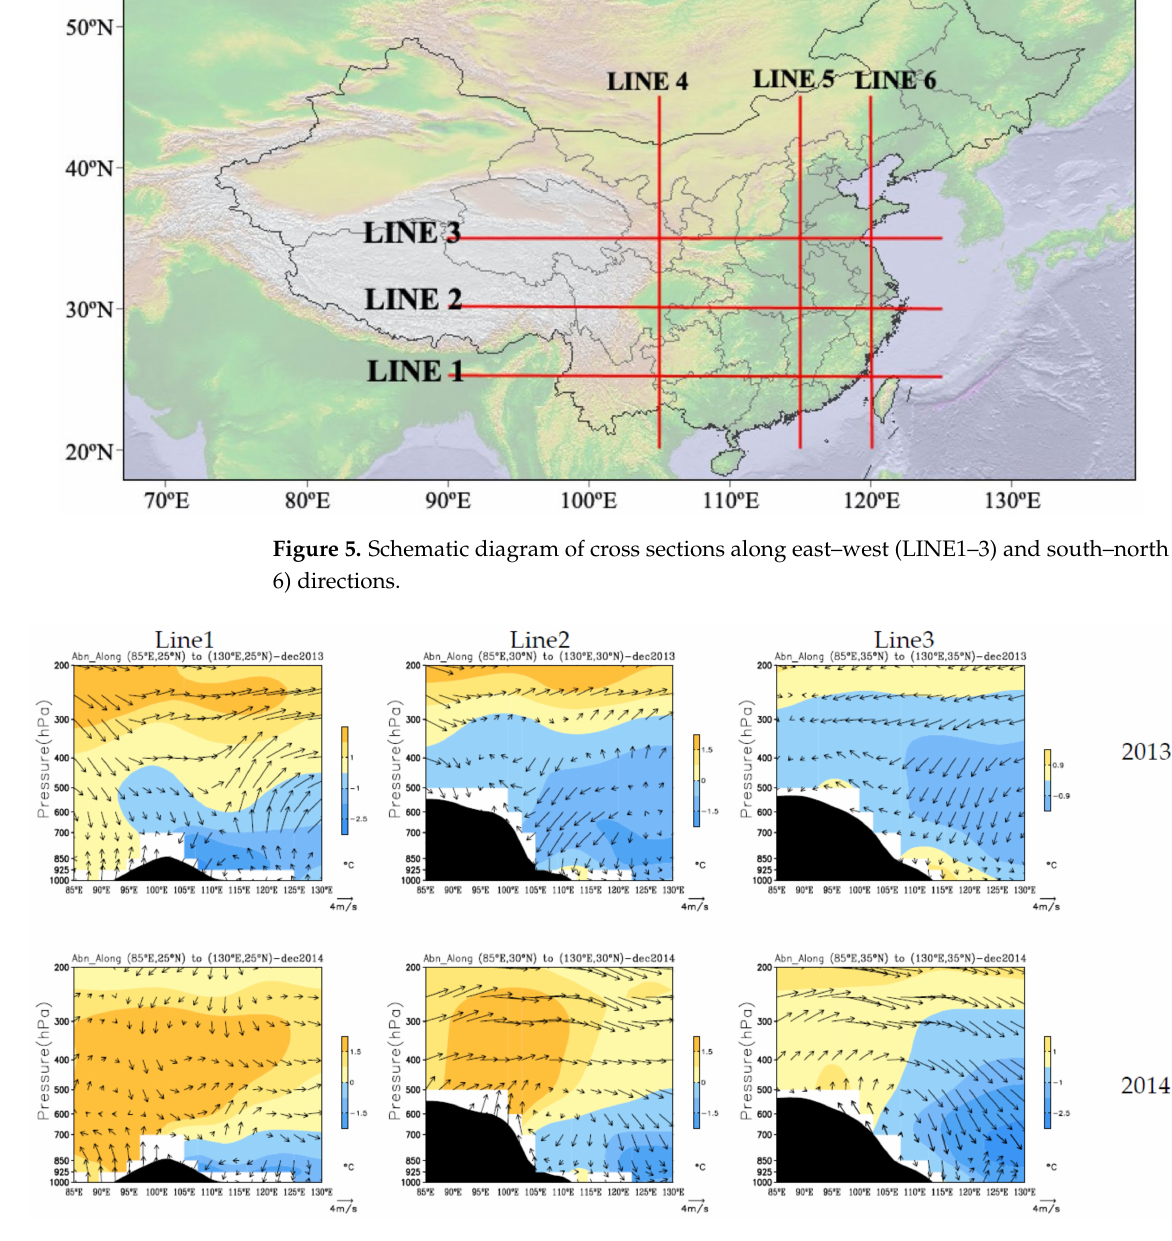
Figure 6. East − west circulation and temperature cross sections of profile 1 ( left ), profile 2 ( middle ) and profile 3 ( right ) in the 2013 ( top ) and 2014 ( bottom ) strong cold source − strong winter mon- soon